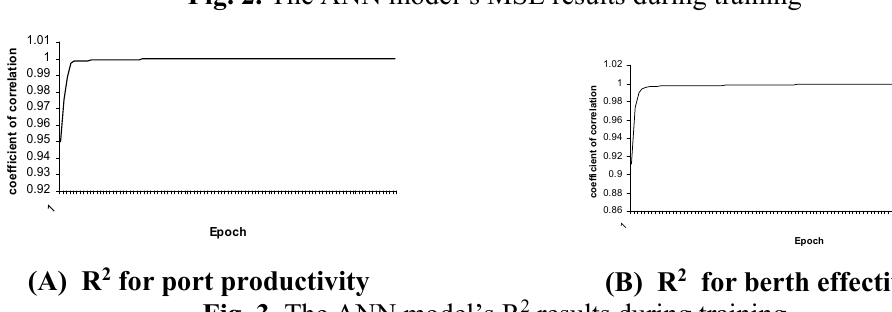
Fig. 2. The ANN model’s MSE results during